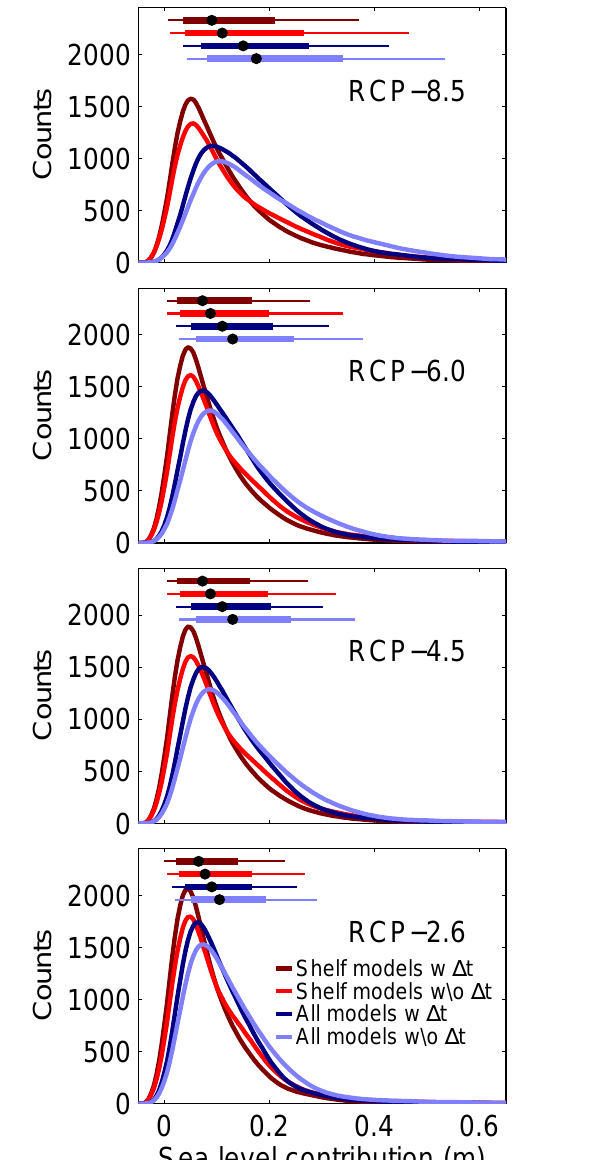
Figure 12. Uncertainty range including climate, ocean and ice- sheet uncertainty. Different colours represent different setups for the total sea-level contribution from basal ice-shelf melt induced ice discharge for the year 2100. Different panels provide estimates for the four RCP scenarios. Red curves in each panel show the three models with explicit representation of ice shelves (PennState-3D, PISM, SICOPOLIS). Blue curves show all models. Dark colours represent simulations using the time delay of Tables 2–5. Light coloured lines give distributions without time lag. All distribu- tions are highly skewed towards high sea-level contributions which strongly influences the median (black dot), the 66% range (thick horizontal line at top) and the 90% range (thin horizontal line at top). The scenario dependence of each of these estimates is also visible in the number provided in Table